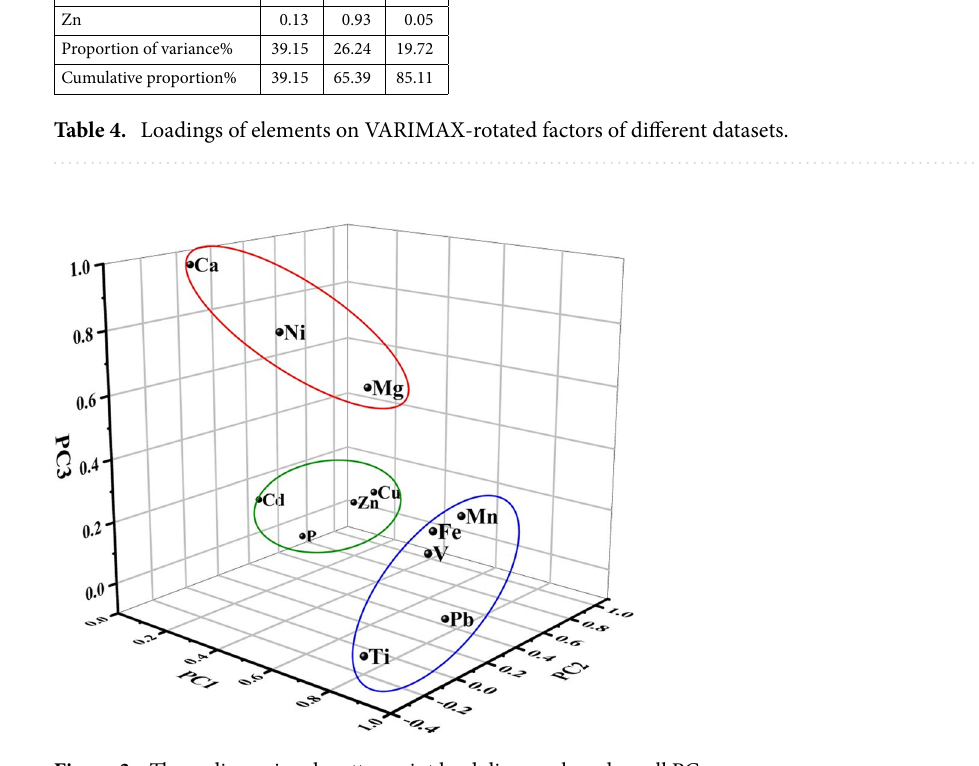
Figure 3. Three-dimensional scatter point load diagram based on all